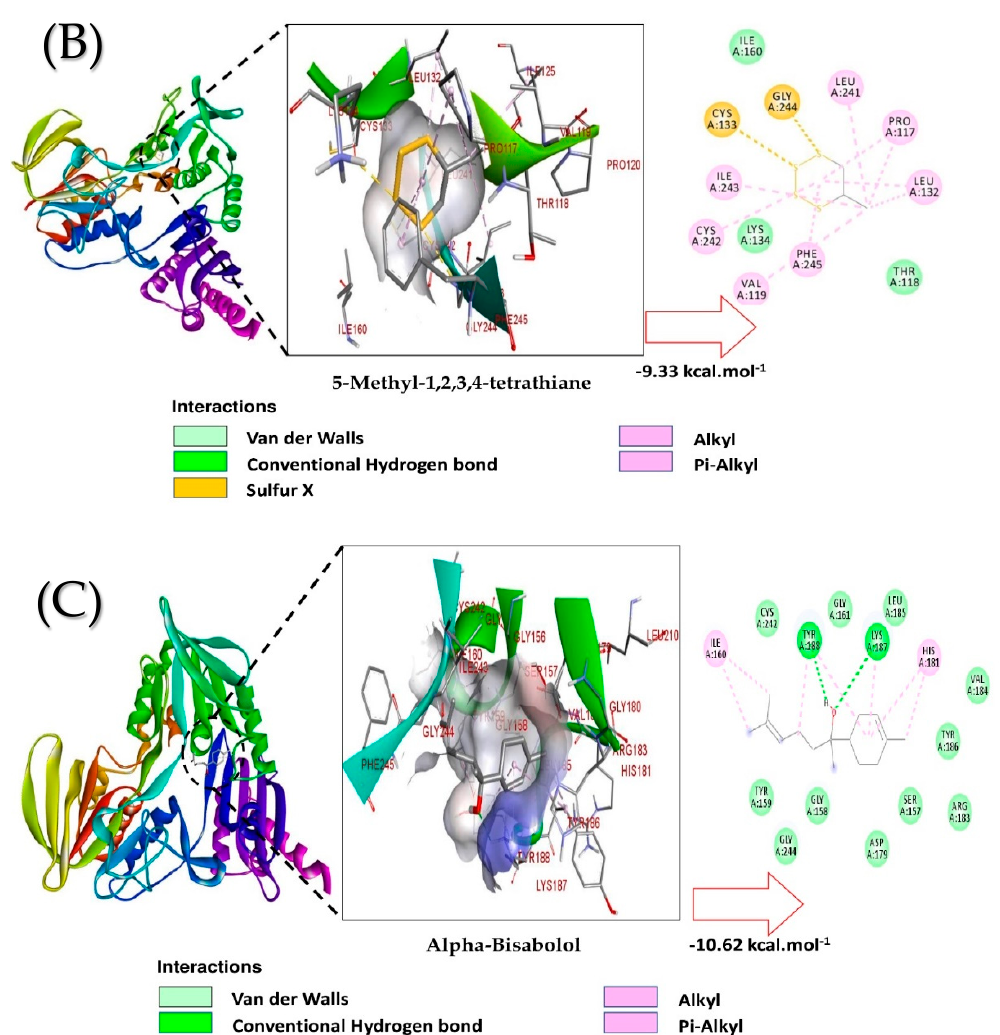
Figure 1. Molecular interaction studies of the most active phytochemical constituents of garlic essential oil with NADPH oxidase (PDB ID: 2CDU). ( A ): 4H-1,2,3-trithiine, ( B ): 5-methyl-1,2,3,4-tetrathiane, and ( C ): α -bisabolol. Surface view (left panel), and 2D (right panel) interactions.